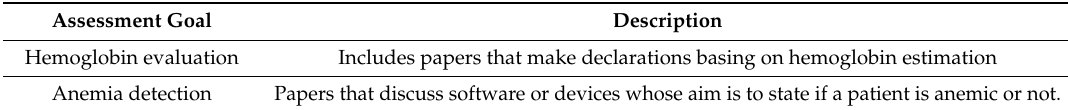
Figure 9. Distribution of papers by classification type. Table 6. Taxonomy of types of publication. Publication Type Description